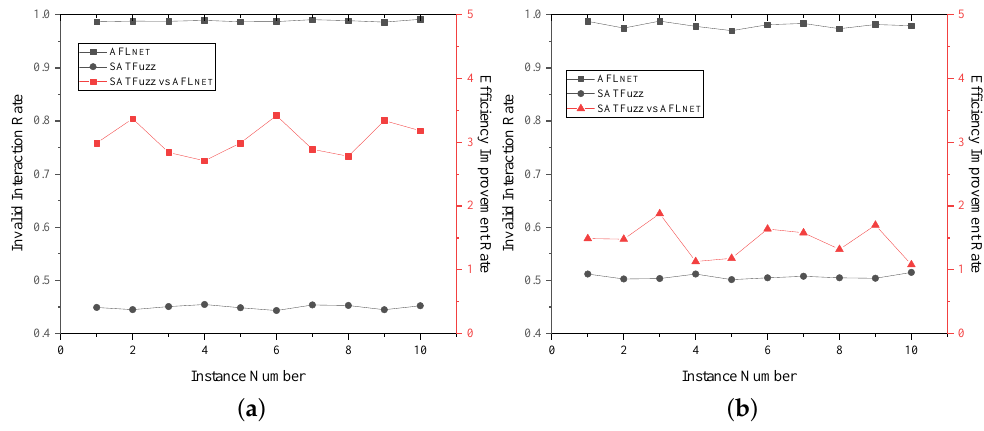
Figure 7. Comparison of the experimental results produced by AFL NET and SATFuzz. ( a ) LightFTP. ( b )